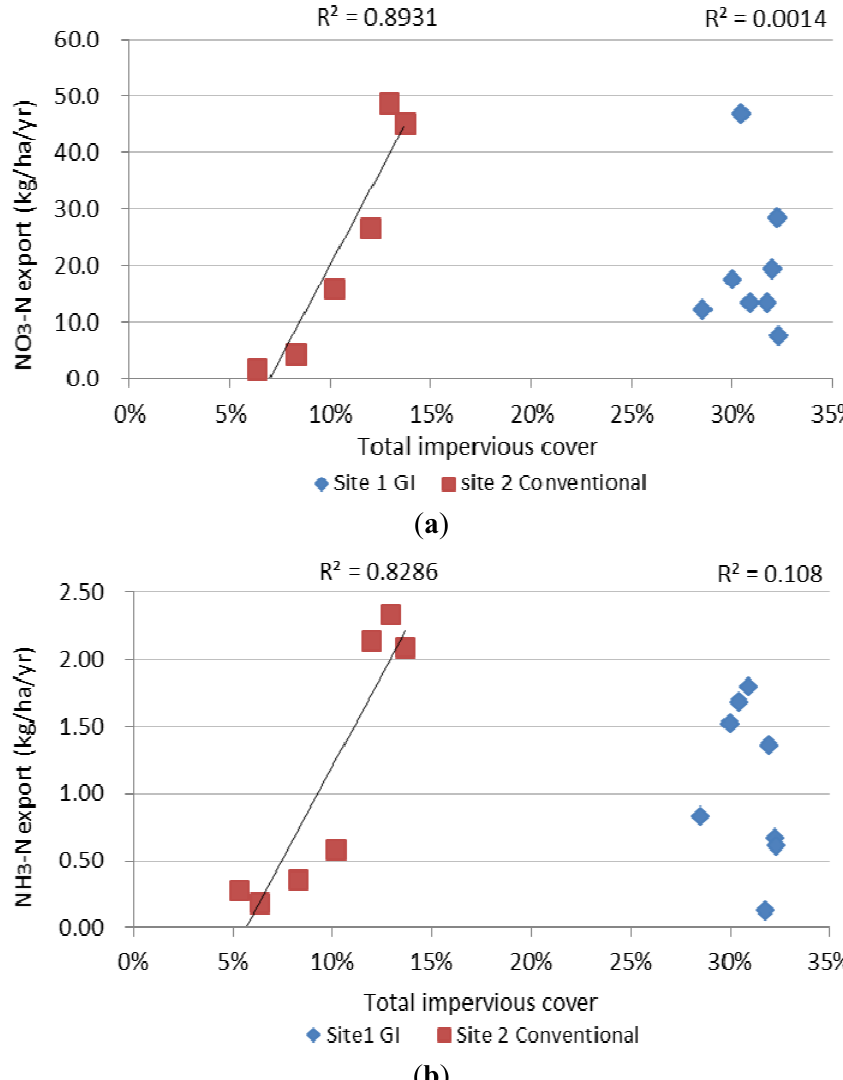
-N, ( b ) NH -N, and ( c ) 3 3